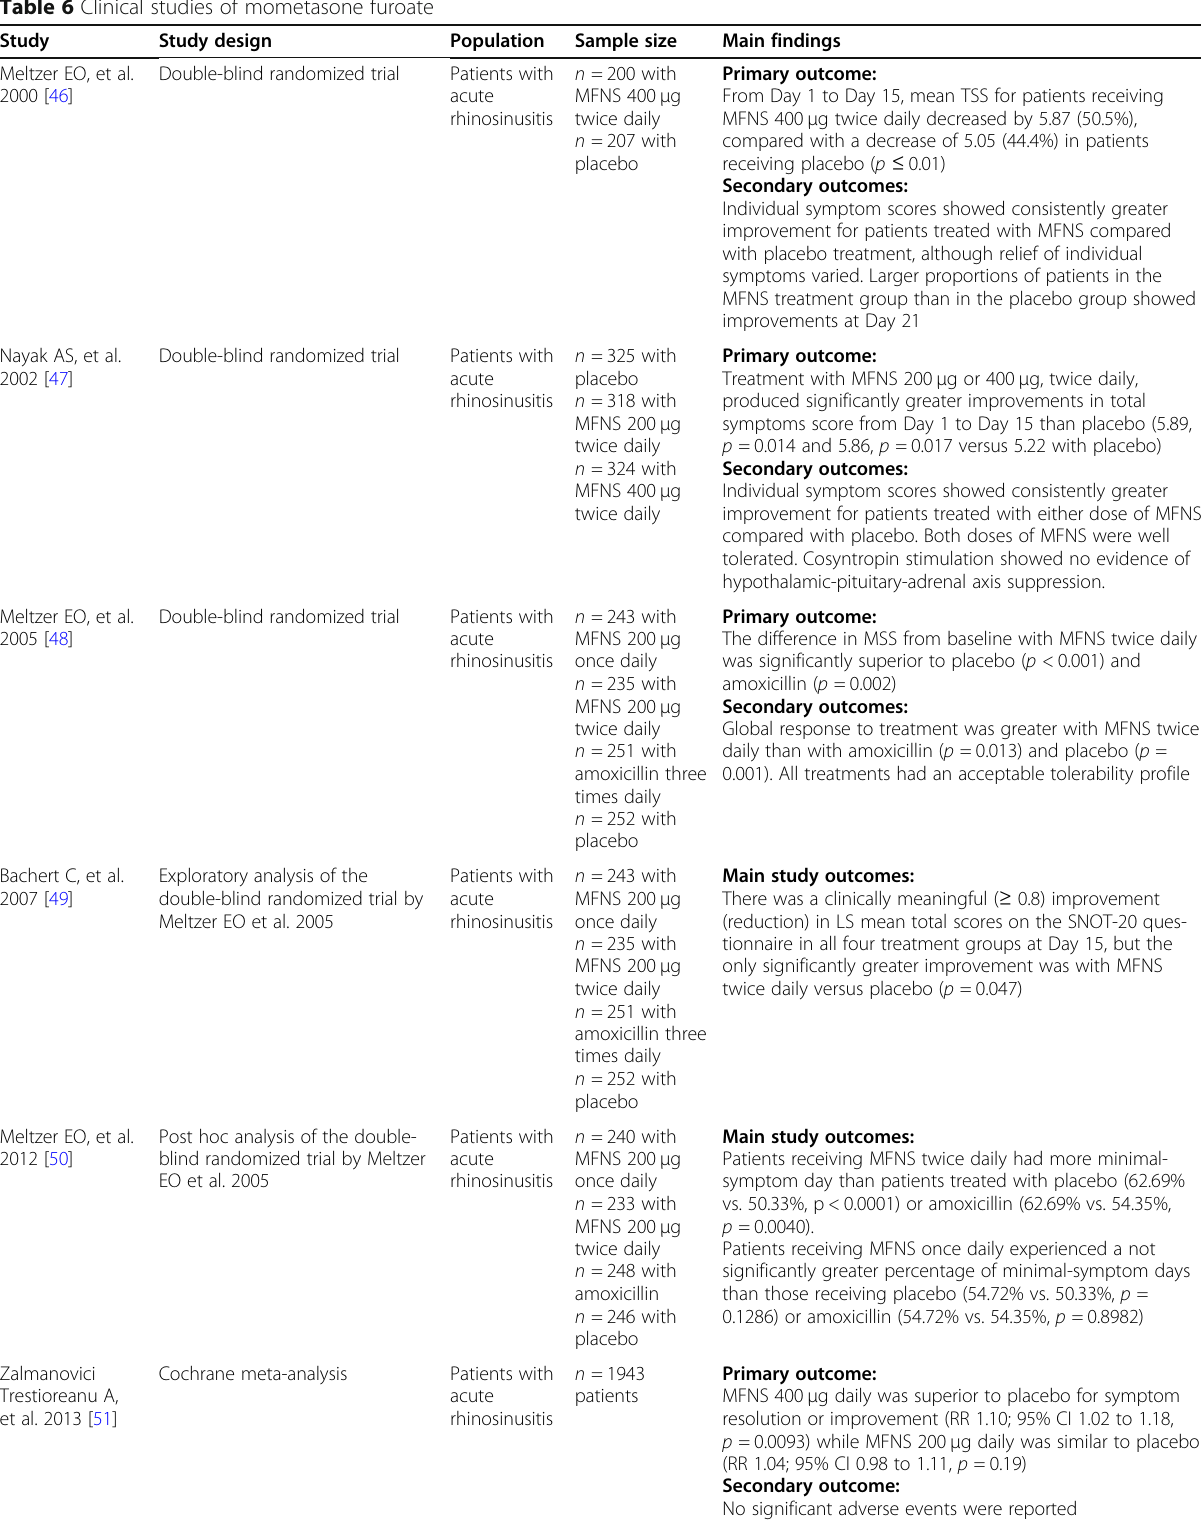
Table 6 Clinical studies of mometasone furoate